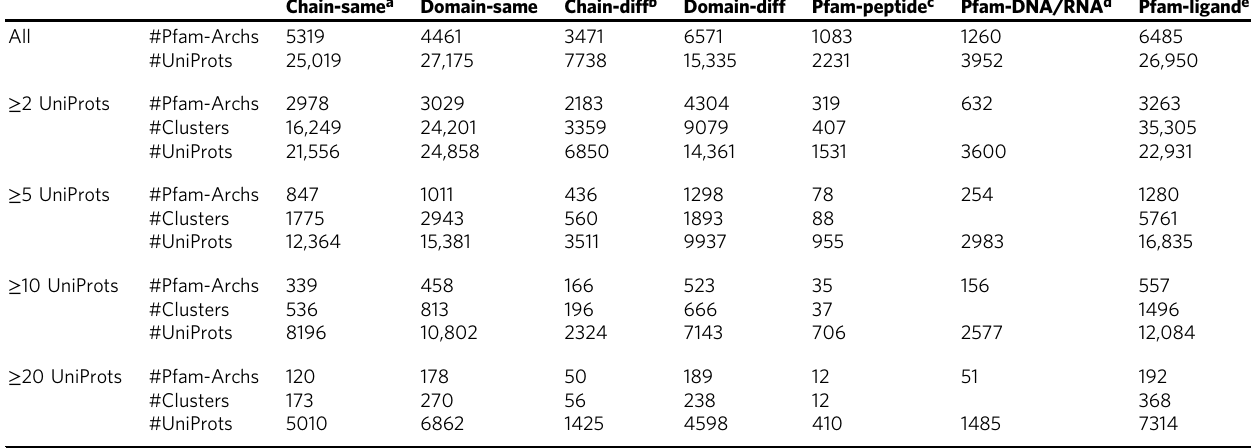
Table 1 Summary of ProtCID